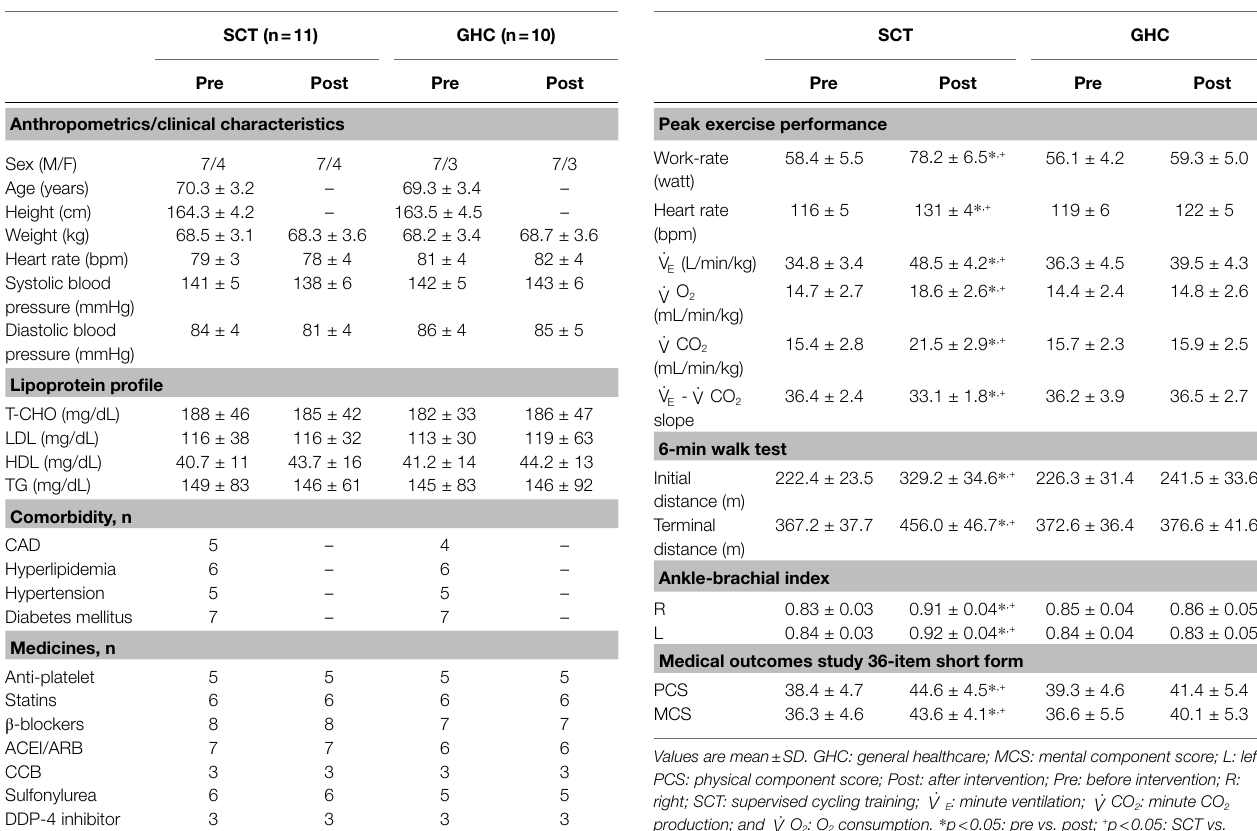
TABLE 2 | Pre- and post-intervention effects on lower-extremity pulse, cardiorespiratory fitness, and health-related quality of life in the SCT and GHC participants.